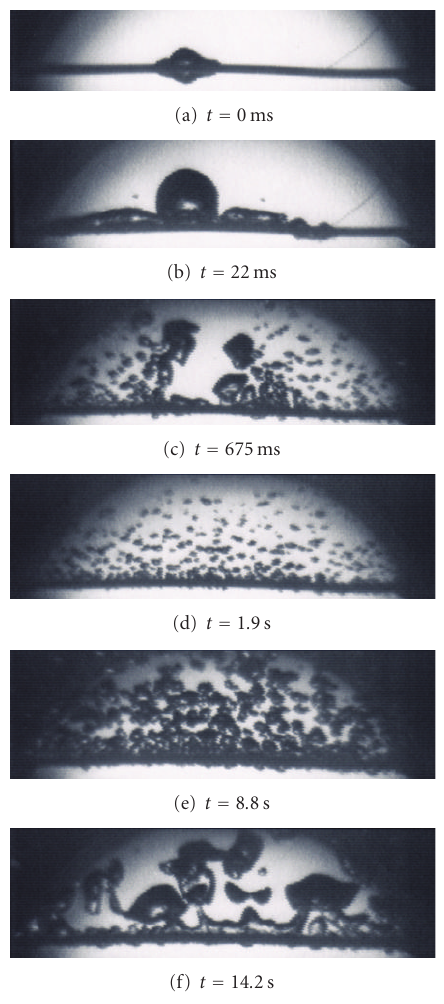
Figure 14: Vapor film behavior during transition to FDNB for a period of 10 s at atmospheric pressure in saturated FC-72 with the CS